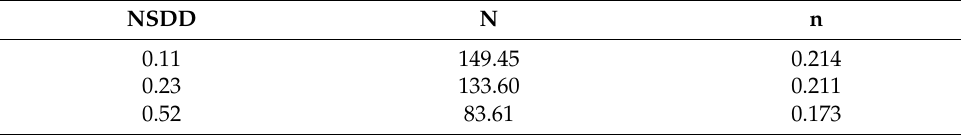
Table 6. Values of parameters n and N for fog rate 3 l/h.